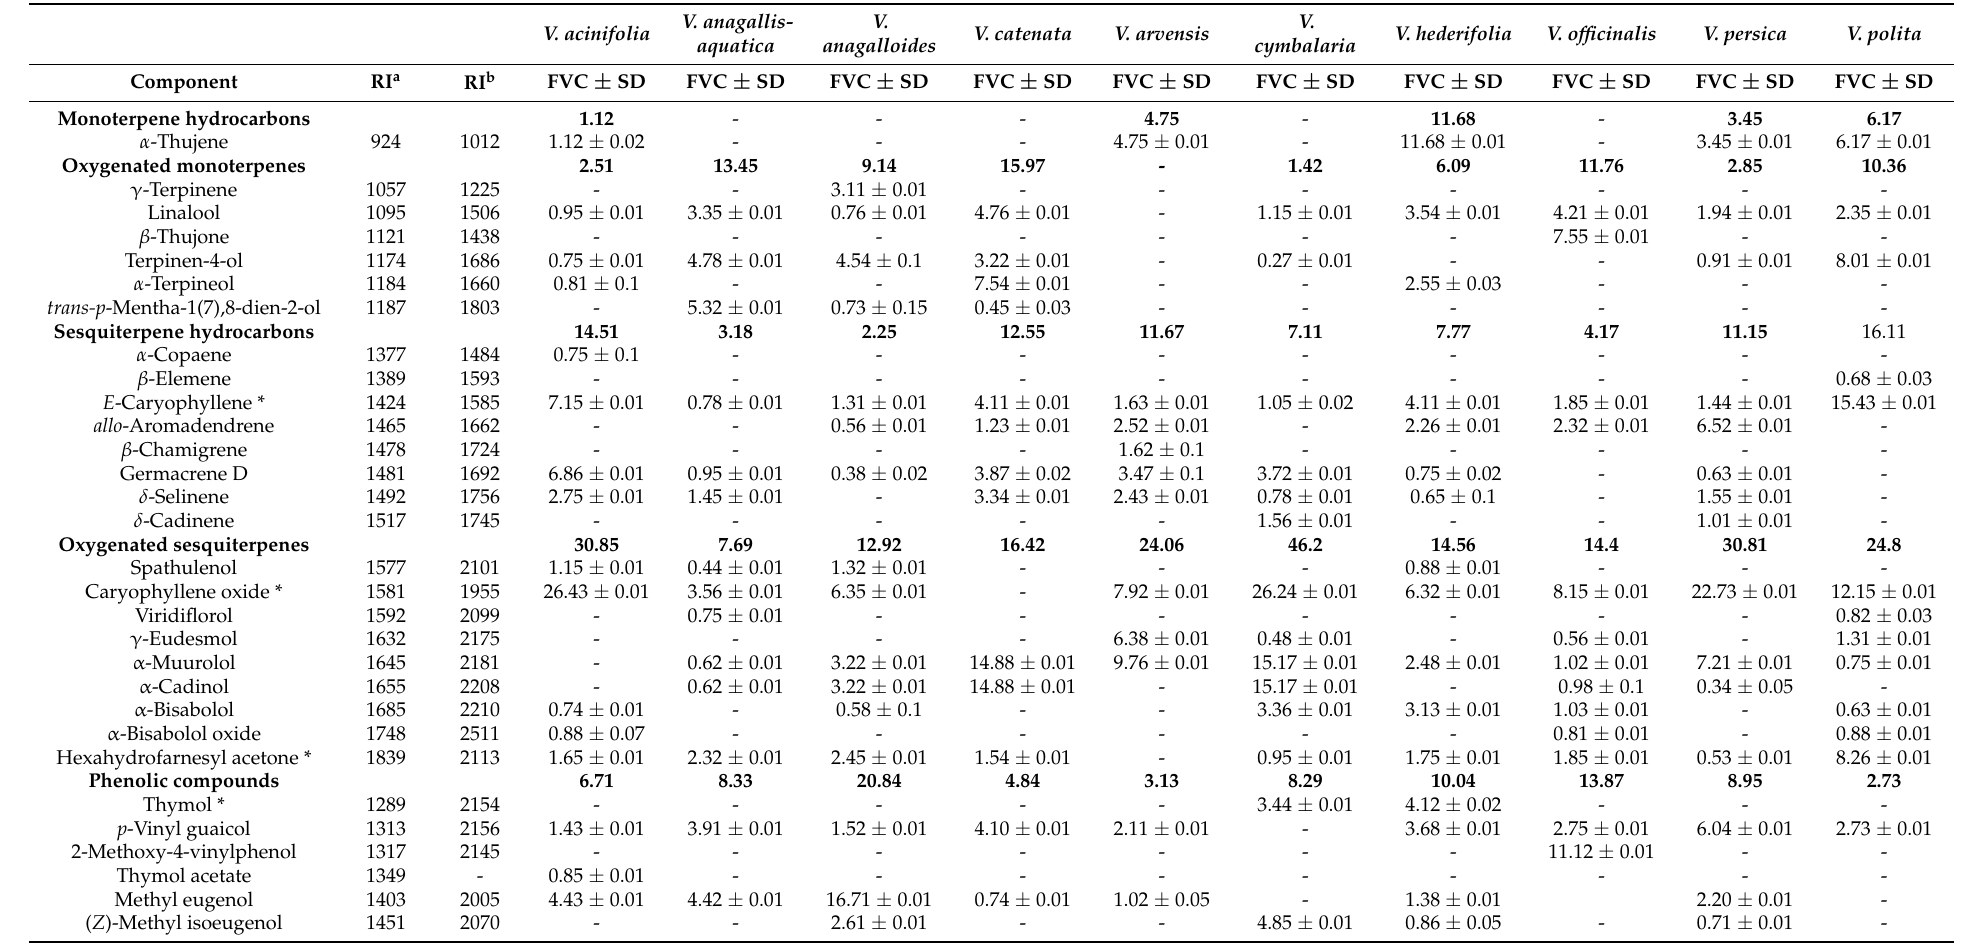
Table 1. Free volatile compounds (FVCs) of the hydrosols obtained by hydrodistillation from the aerial parts of Veronica